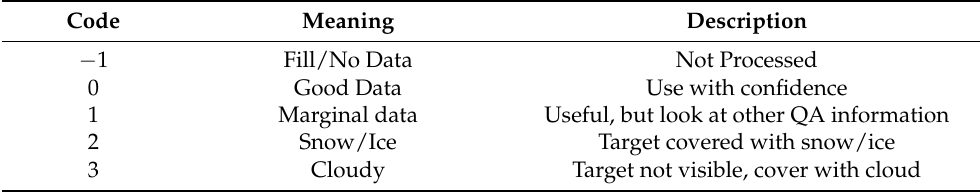
Table 1. Codes used in the MOD13Q1/Pixel Reliability (PR) layer. Code Meaning Description − 1 Fill/No Data Not Processed Good Data Use with confidence Marginal data Useful, but look at other QA information Snow/Ice Target covered with snow/ice Cloudy Target not visible, cover with cloud